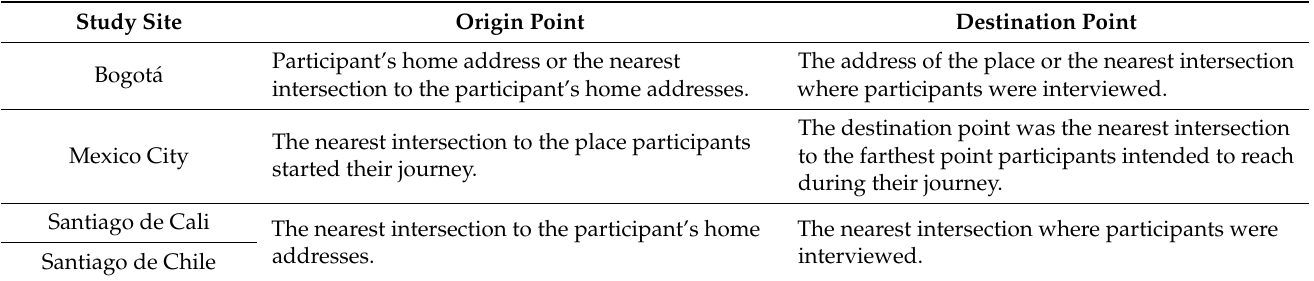
Table 2. Origin and departure points by study